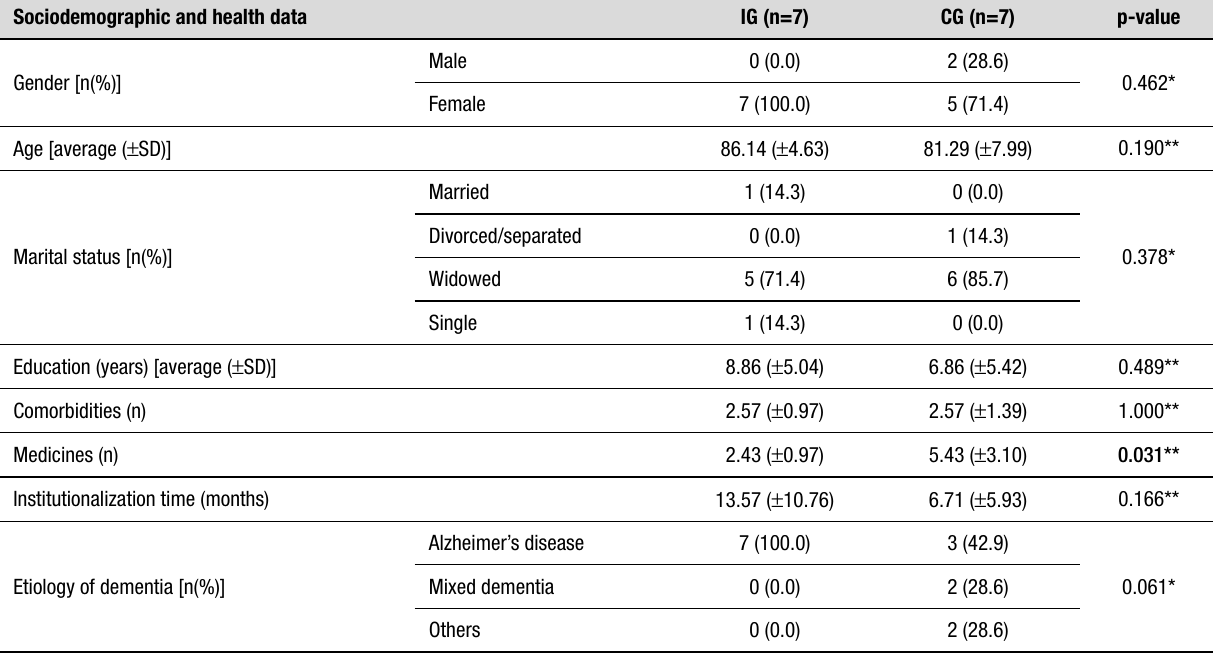
Table 1. Sociodemographic and health data of the intervention group and control group (n=14). São Carlos, SP, 2021. Sociodemographic and health